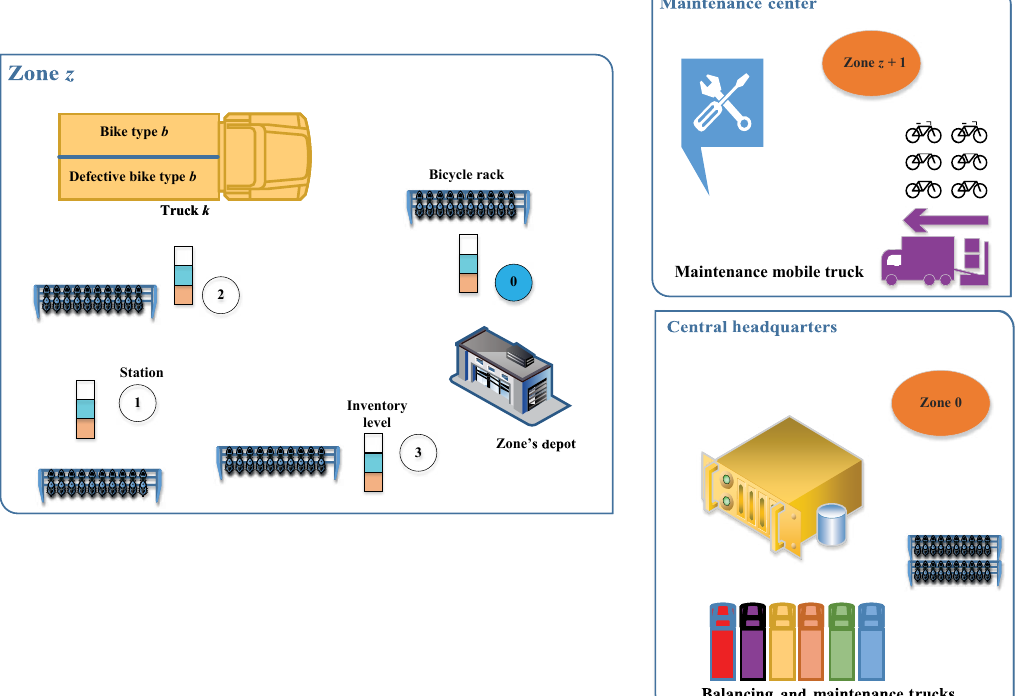
Figure 1. Conceptual model of the